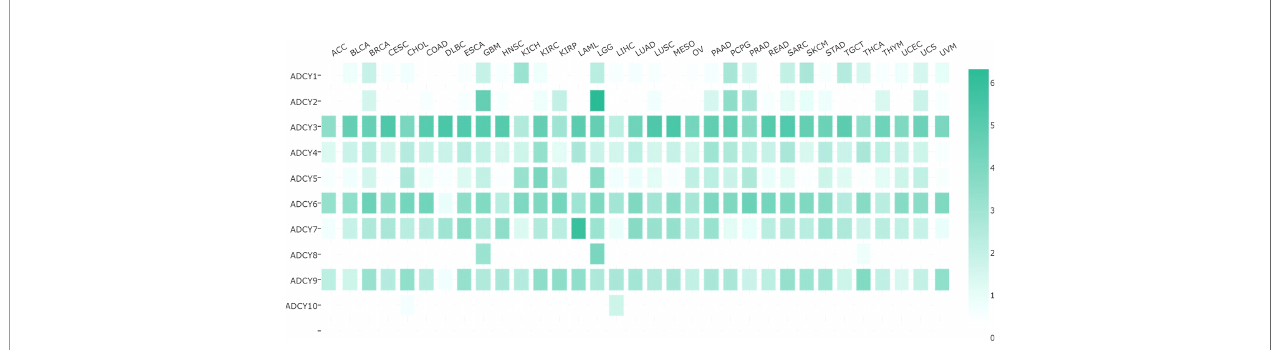
FIGURE 4 | Comparison of the expression of various ACDY isoforms in different cancers. The adenylate cyclase gene is expressed differently in each cancer, with darker color indicating higher expression and vice versa. ACC, adrenocortical carcinoma; BLCA, bladder urothelial carcinoma; BRCA, breast invasive carcinoma; CESC, cervical squamous cell carcinoma and endocervical adenocarcinoma; CHOL, cholangiocarcinoma; COAD, colon adenocarcinoma; DLBC, lymphoid neoplasm diffuse large B-cell lymphoma; ESCA, esophageal carcinoma; GBM, glioblastoma multiforme; HNSC, head and neck squamous cell carcinoma; KICH, kidney chromophobe; KIRC, kidney renal clear cell carcinoma; KIRP, kidney renal papillary cell carcinoma; LAML, acute myeloid leukemia; LGG, brain lower-grade glioma; LIHC, liver hepatocellular carcinoma; LUAD, lung adenocarcinoma; LUSC, lung squamous cell carcinoma; MESO, mesothelioma; OV, ovarian serous cystadenocarcinoma; PAAD, pancreatic adenocarcinoma; PCPG, pheochromocytoma and paraganglioma; PRAD, prostate adenocarcinoma; READ, rectum adenocarcinoma; SARC, sarcoma; SKCM, skin cutaneous melanoma; STAD, stomach adenocarcinoma; TGCT, testicular germ cell tumors; THCA, thyroid carcinoma; THYM, thymoma; UCEC, uterine corpus endometrial carcinoma; UCS, uterine carcinosarcoma; UVM, uveal